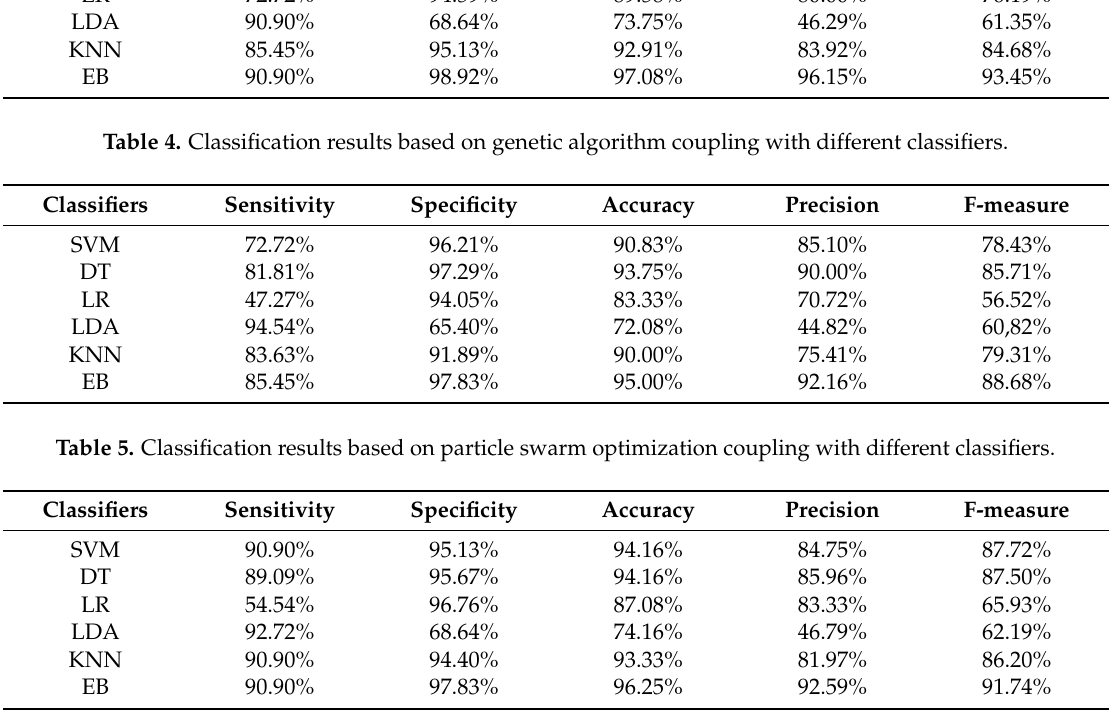
Table 6. Classification results based on hybrid ant colony optimization coupling with different